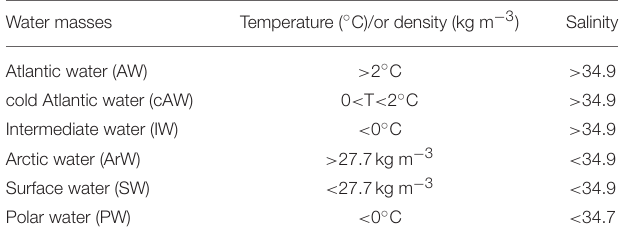
TABLE 1 | Criteria determining the water